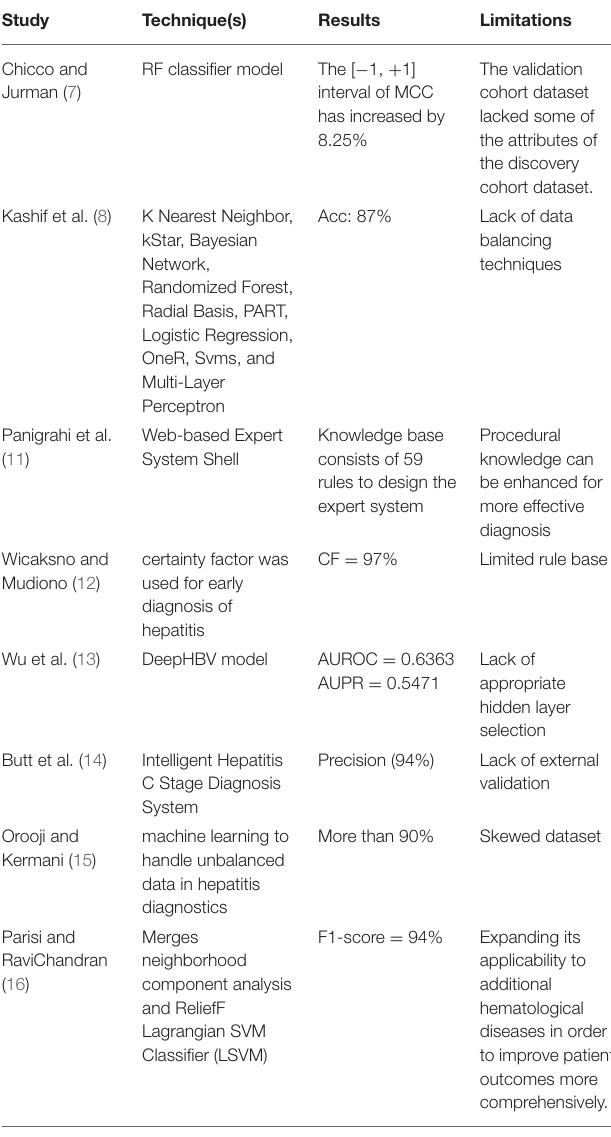
TABLE 1 | A review of selected